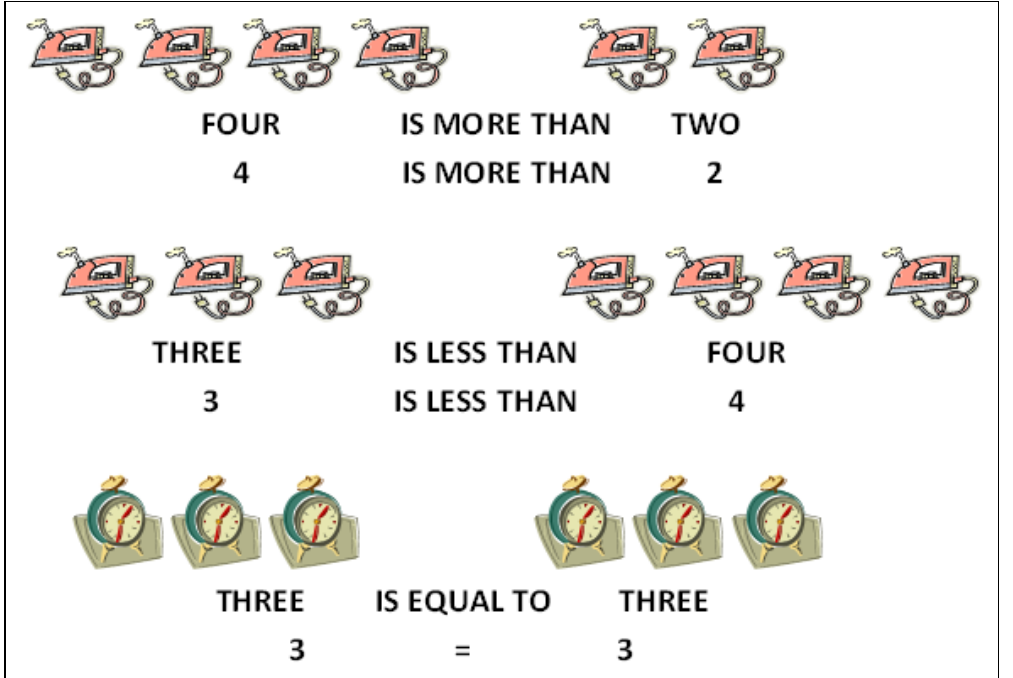
Figure 4 : A suggested approach to introduce the equal